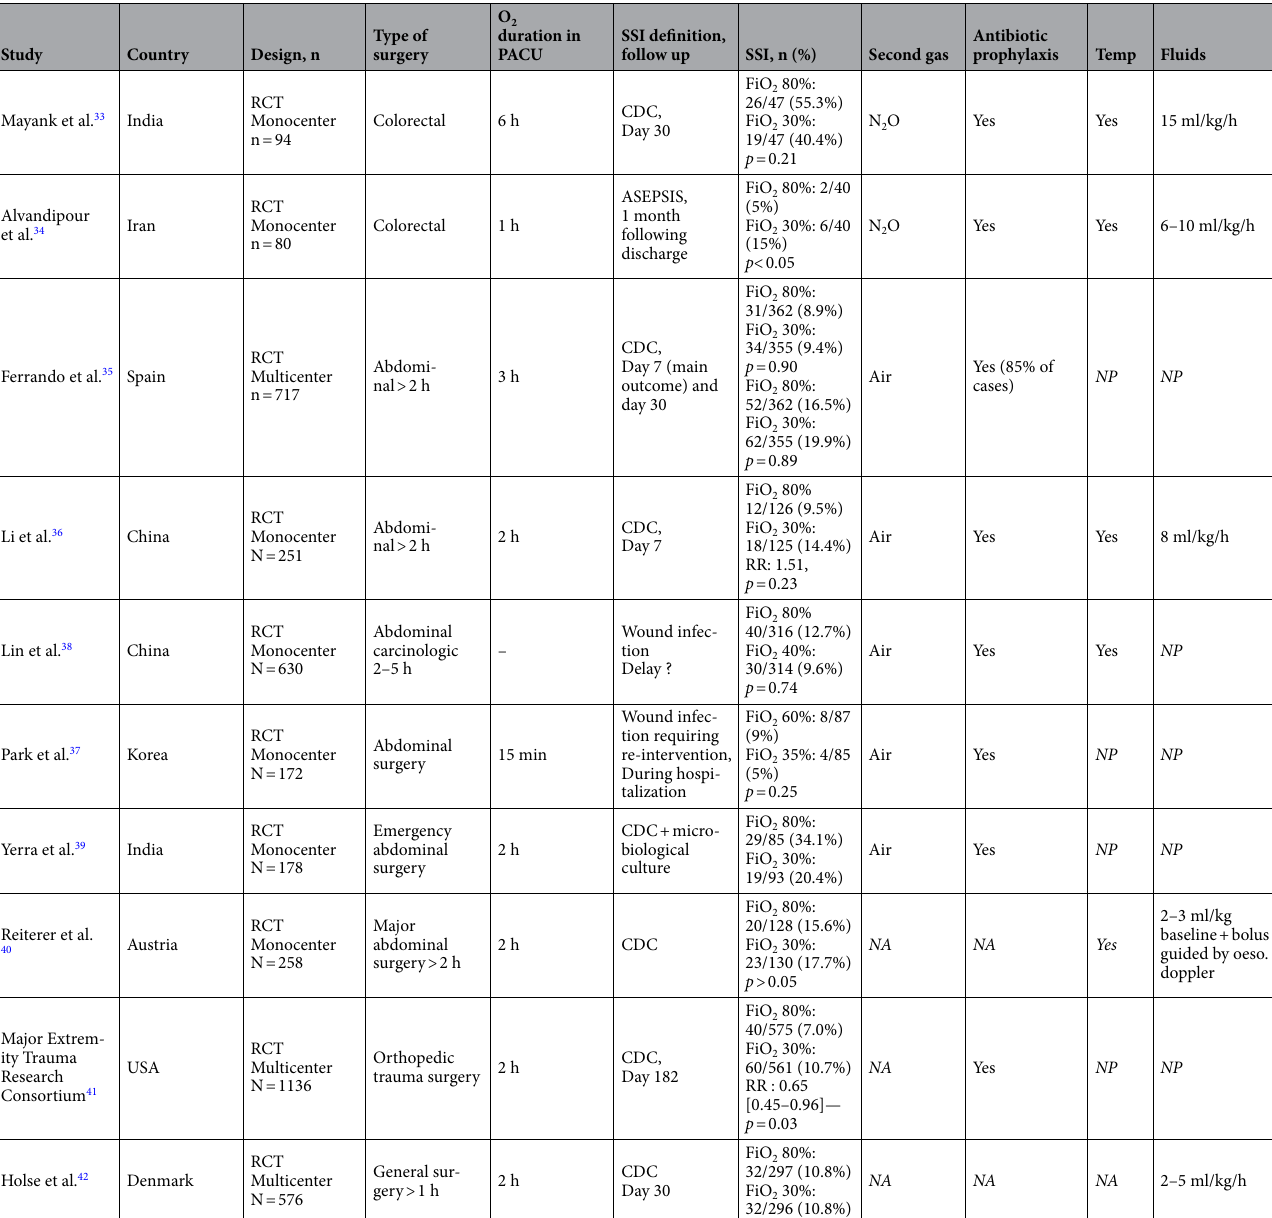
Table 1. Summary of the main characteristics and results of the studies including patients under general anesthesia.